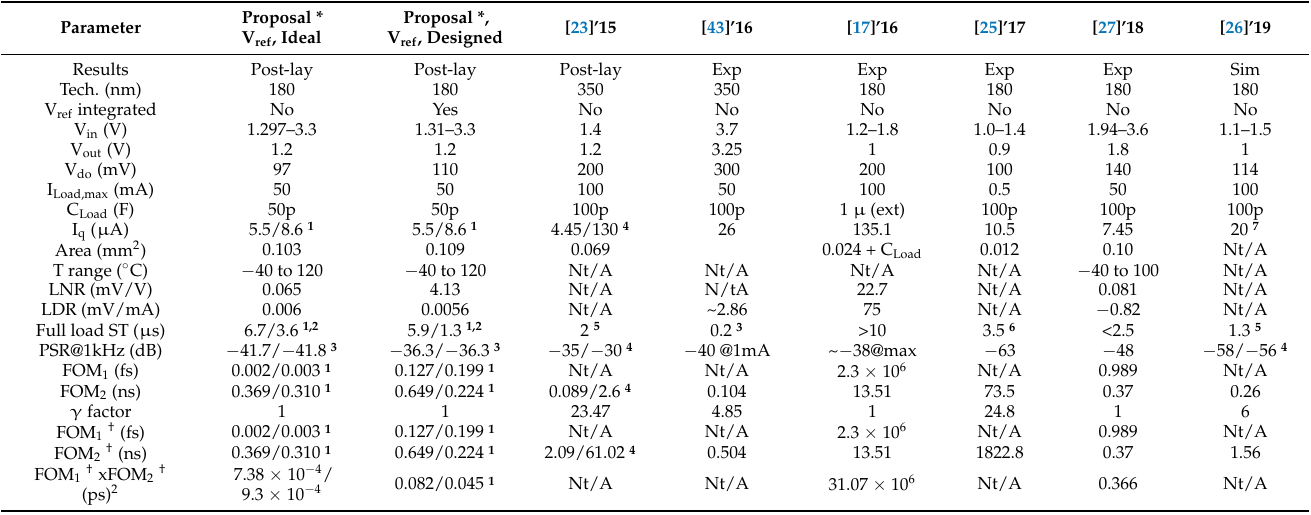
Table 1. Performance summary of the main characteristics of the reported and state-of-art LDO regulators.